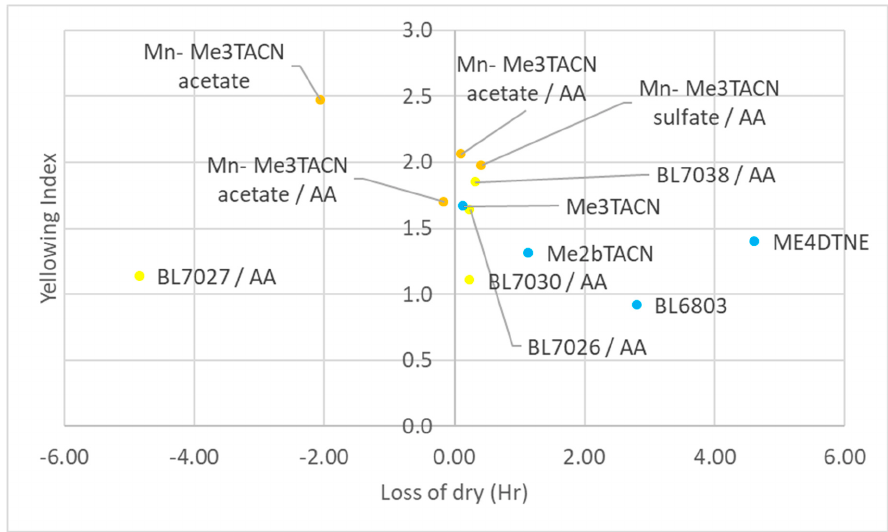
Figure 13. Combined Yellowing index and loss of dry data for selected Me 3 TACN